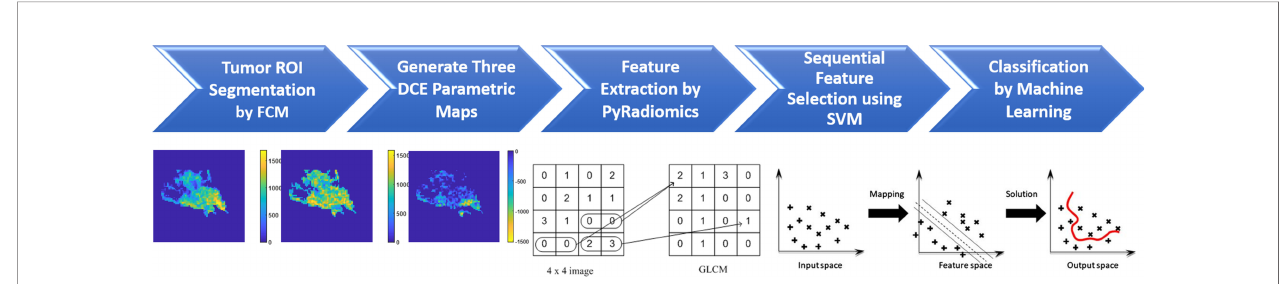
FIGURE 5 | The fl owchart of the radiomics analysis procedures. The tumor is fi rst segmented on F2 – F1 subtraction image using the FCM algorithm, and then the tumor ROI is mapped to three generated DCE parametric maps. On each map, 107 parameters are extracted using PyRadiomics. They are used for feature selection by SVM, and then for building classi fi cation models using fi ve different machine learning